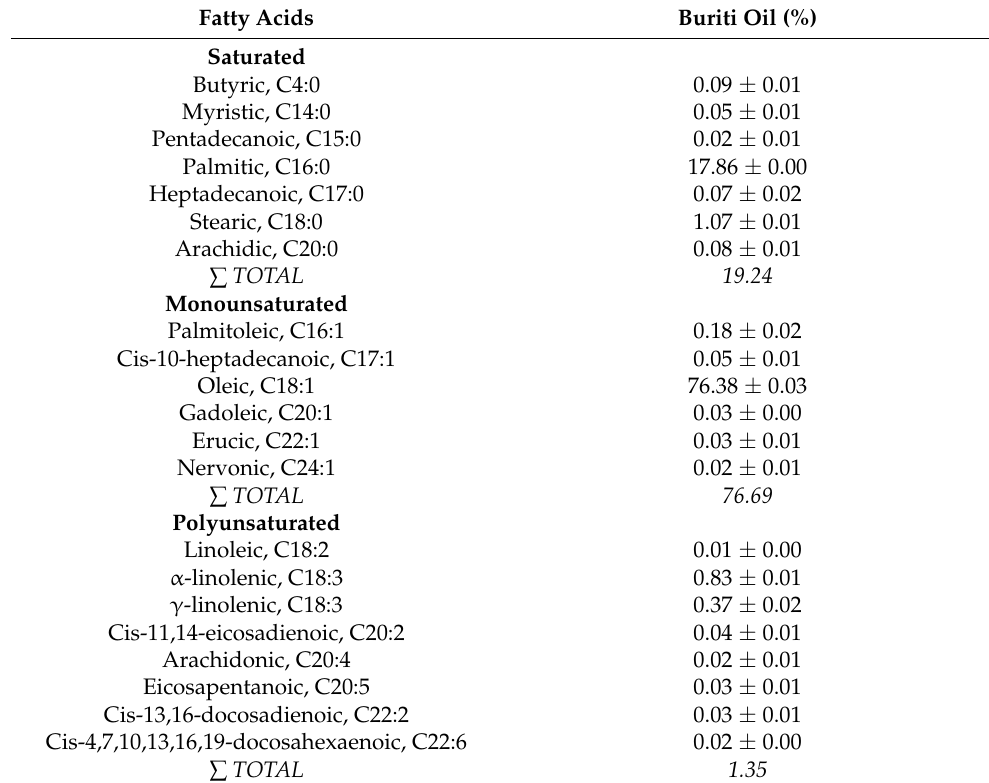
Table 1. Fatty acid profile (%) of buriti oil.